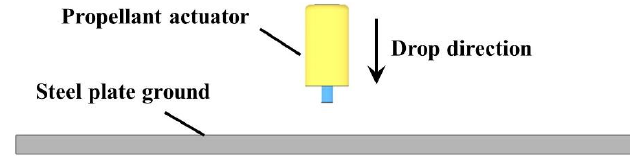
Figure 13. Axially accidental drop of propellant actuator.